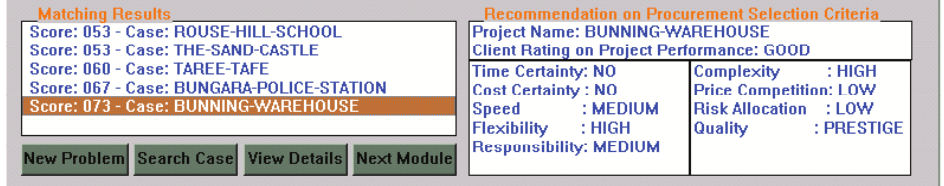
Figure 6: Cases retrieved during PSPs formulation stage